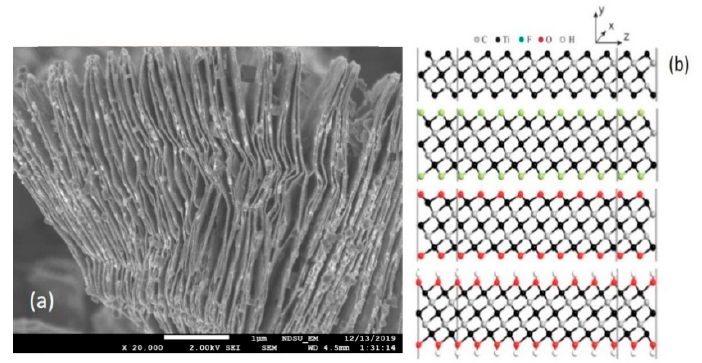
Figure 2. Newly synthesized 2D multilayered Ti 3 C 2 MXene nanosheets ( a ) Scanning electron mi- croscope (SEM) image; ( b ) pristine and surface-terminated Ti 3 C 2 MXene with different functional groups